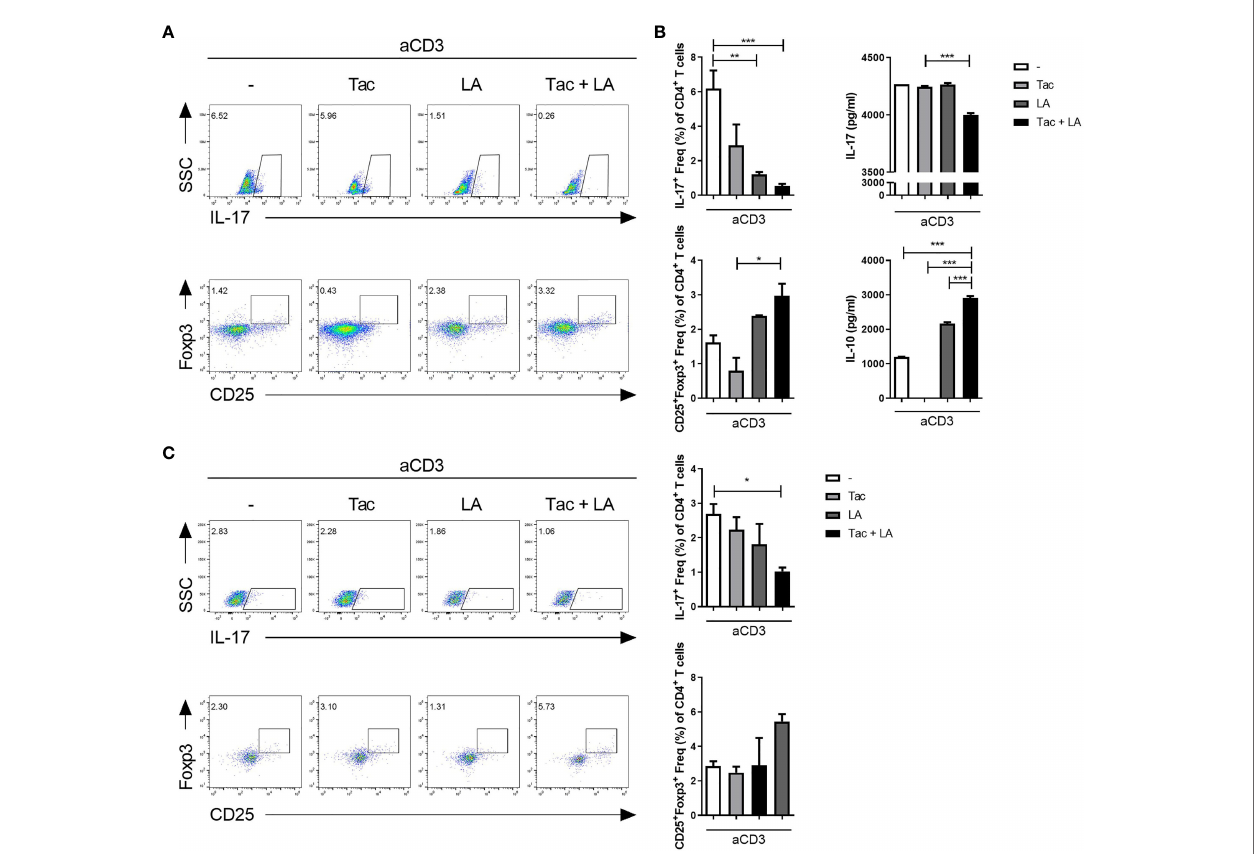
FIGURE 6 | In vitro treatment with the combination of Tac and LA modulates the Th17/Treg balance in human peripheral blood. Peripheral blood mononuclear cells (PBMCs) were isolated from healthy humans (n = 5). Cells were stimulated with anti-CD3 antibodies and treated with Tac and/or LA for 72 h. (A) Flow cytometry analysis of IL-17-expressing cells (Th17 cells) and Foxp3-expressing cells (Treg cells). (B) Levels of IL-17 (upper panels) and IL-10 (lower panels) in the supernatants of cultured cells from the healthy humans. (C) PBMCs from lupus patients (n = 9) were isolated and cultured under anti-CD3 antibody stimulation and treatment with Tac and/or LA for 96 h. Flow cytometry data of the proportions of Th17 (upper panels) and Treg (lower panels) cells. All experiments were performed at least three times in triplicate. Data are shown as mean ± SEM. * p < 0.05, ** p < 0.01, *** p <